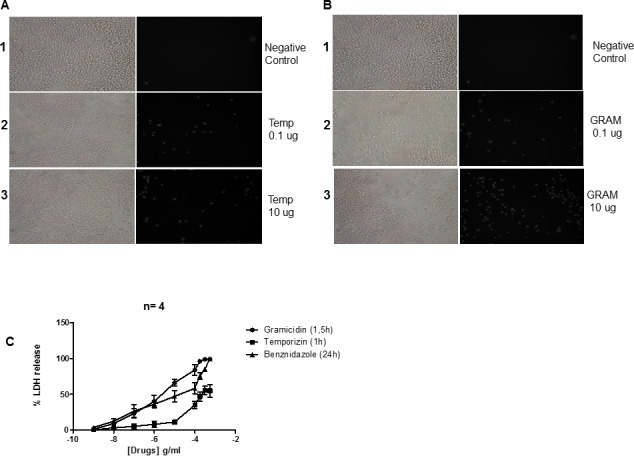
Temporizin causes moderate toxicity in mammalian J774 cells.J774 cell line was incubated at 37°C for 60 minutes in the presence of temporizin (0.1 and 10 μg/ml; Panel A) or gramicidin (0.1 and 10 μg/ml; Panel B), respectively. C: A quantification of the results obtained by PI entry assay after treating J774 cells with temporizin, gramicidin and benznidazole at different concentrations for 60, 90 and 1440 minutes. Gramicidin and temporizin toxicity was quantified by LDH Release Assay. The values represent the mean ± SD of four to six experiments (cell permeabilization assay) and three experiments (LDH release assay) performed on different days. *p<0.05, **p<0.01 compared with the corresponding negative control.